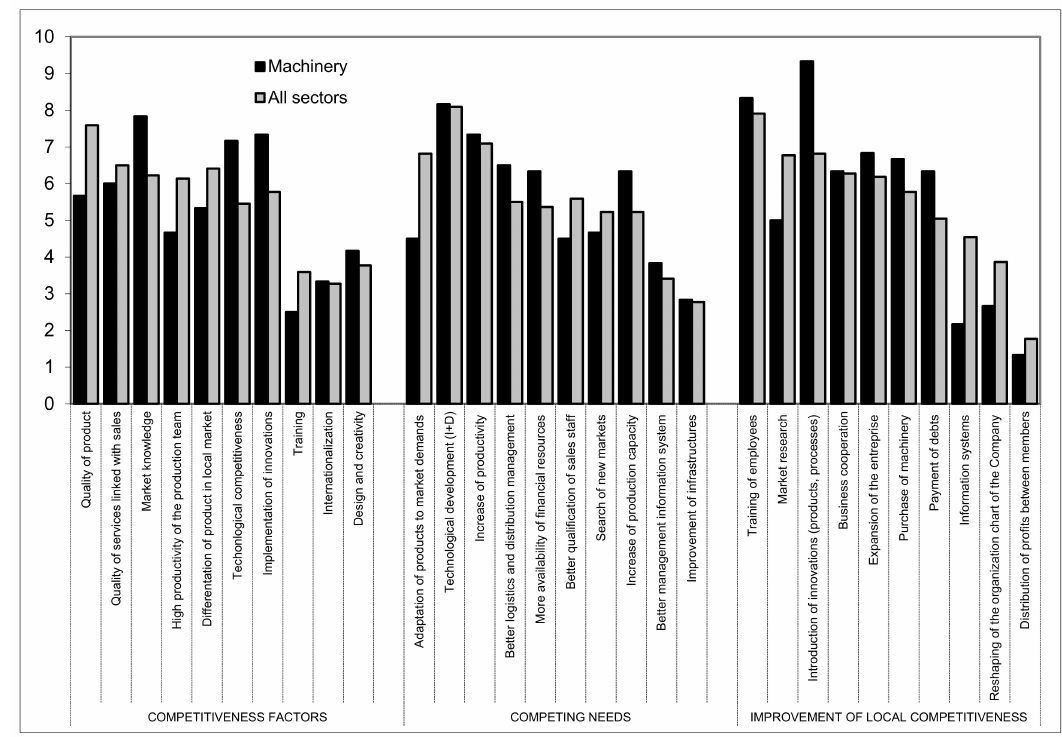
Figure 6. Issues referring to competitiveness of agricultural machinery and tools in relation with other subsectors. Source—Own compilation based on data from Delphi analysis and